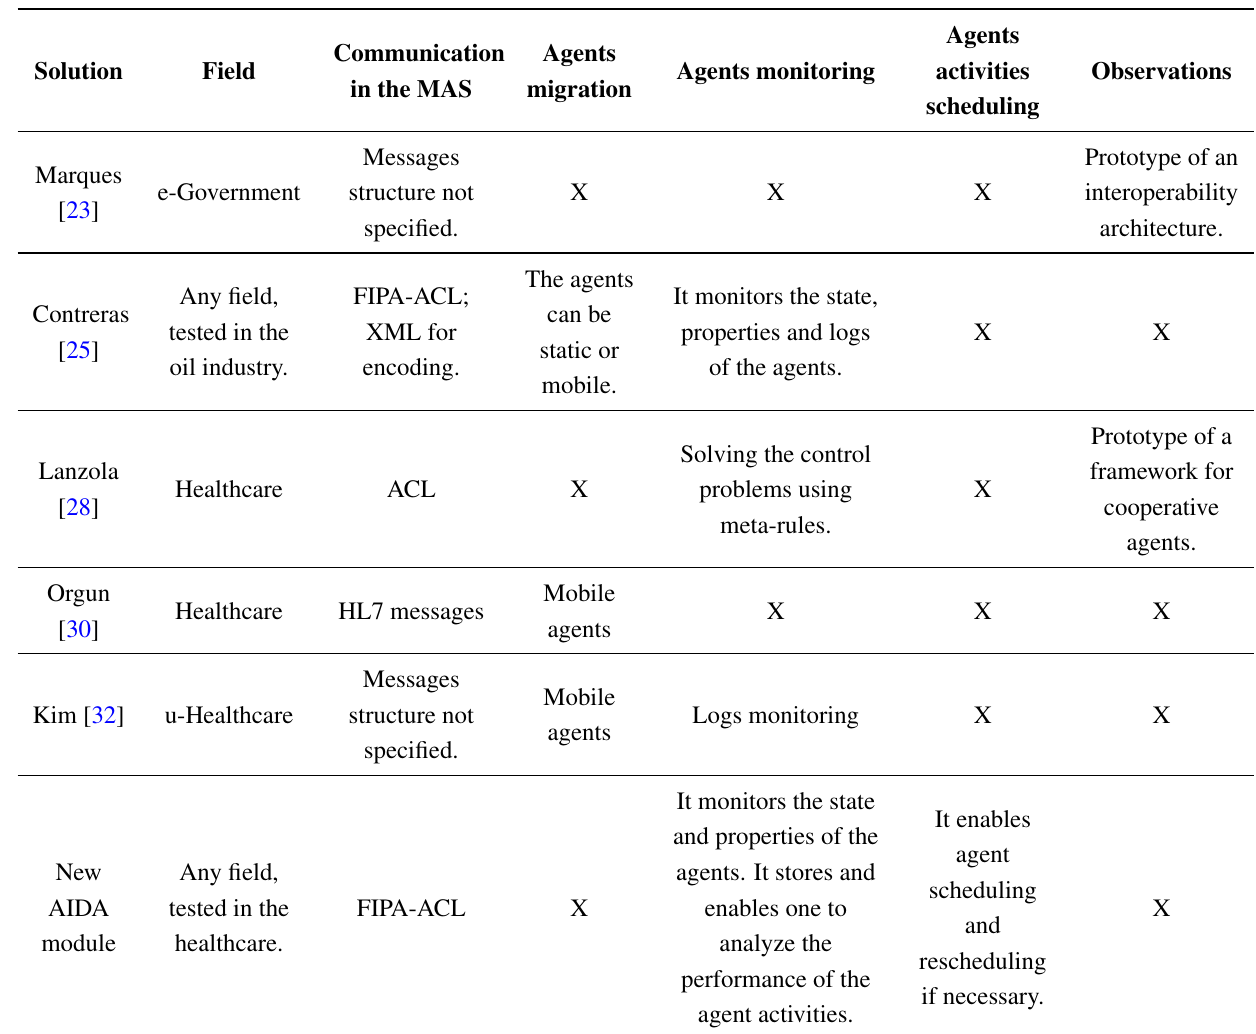
Table 1. Comparison of several solutions. FIPA-ACL, Foundation for Intelligent Physical Agents Agent Communication